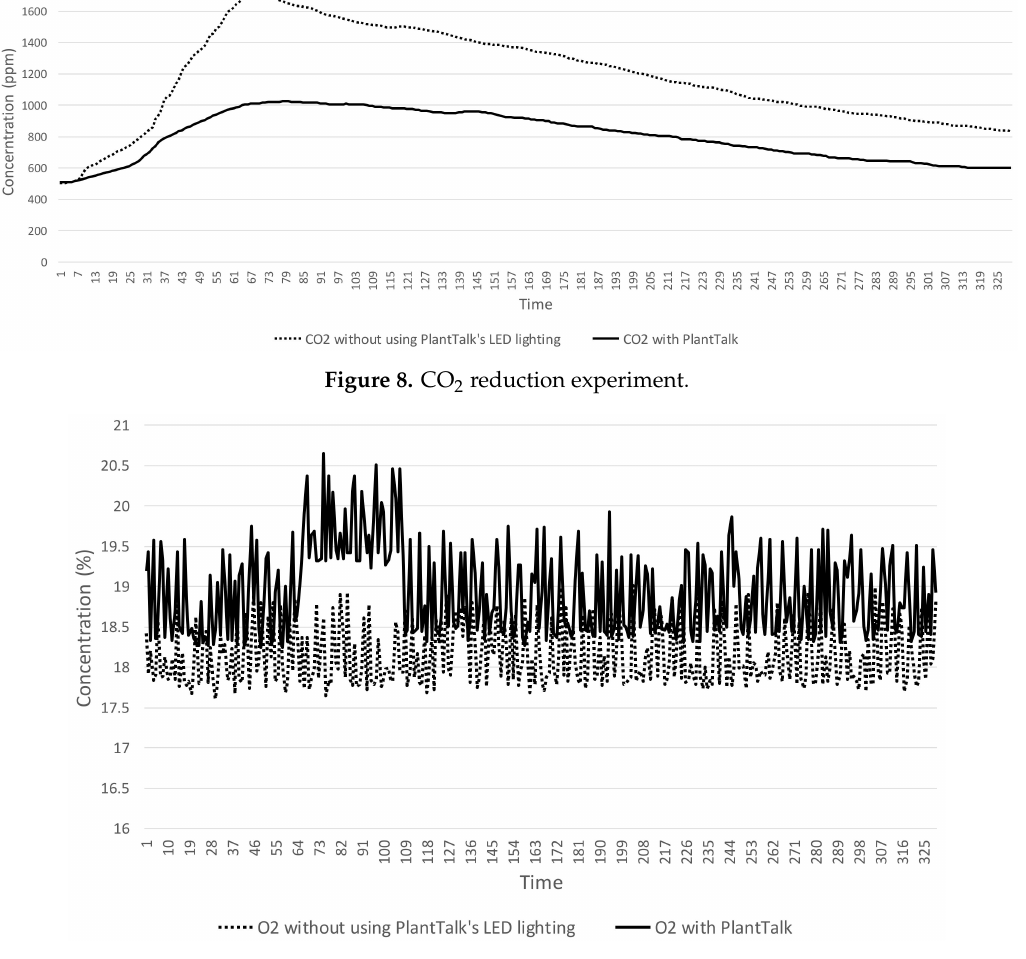
Figure 9. O 2 improvement